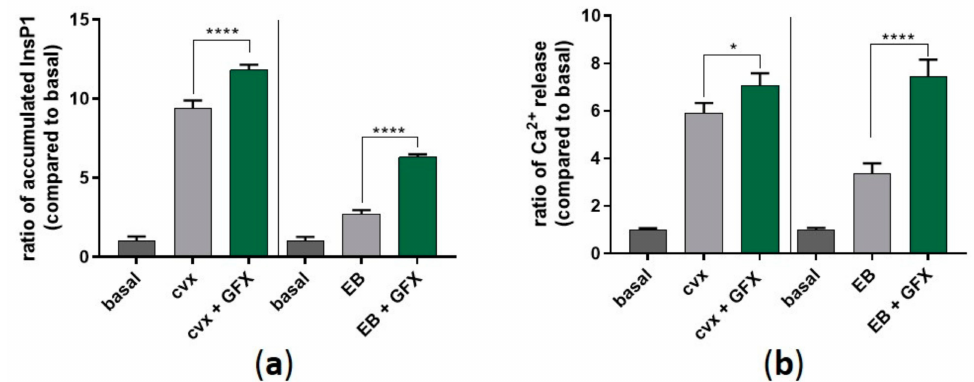
Figure 9. PKC inhibition significantly enhances InsP1 accumulation and intracellular Ca 2 +